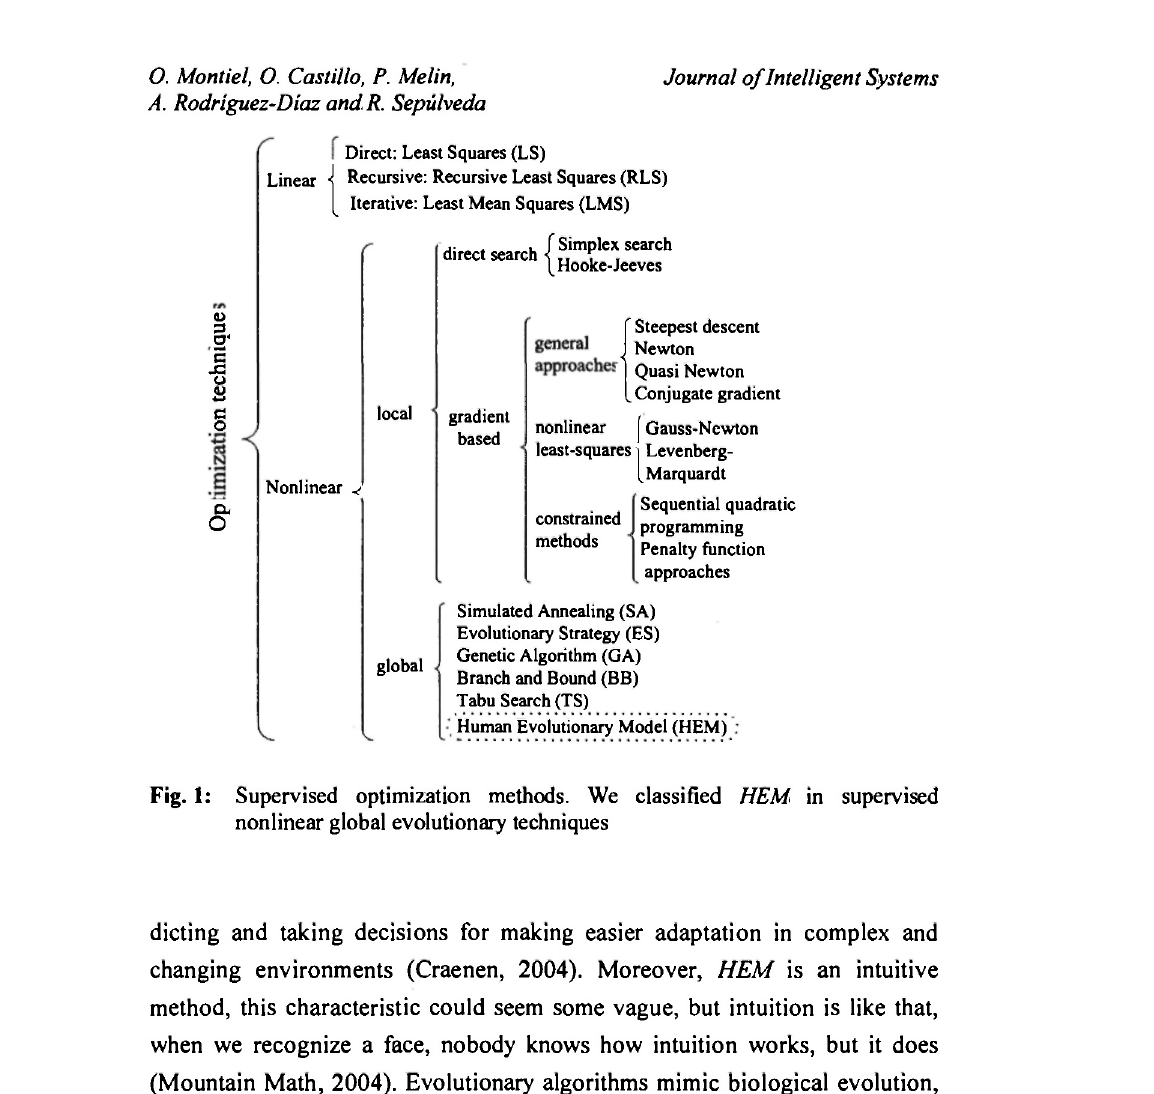
Supervised optimization methods. We classified HEM in supervised nonlinear global evolutionary